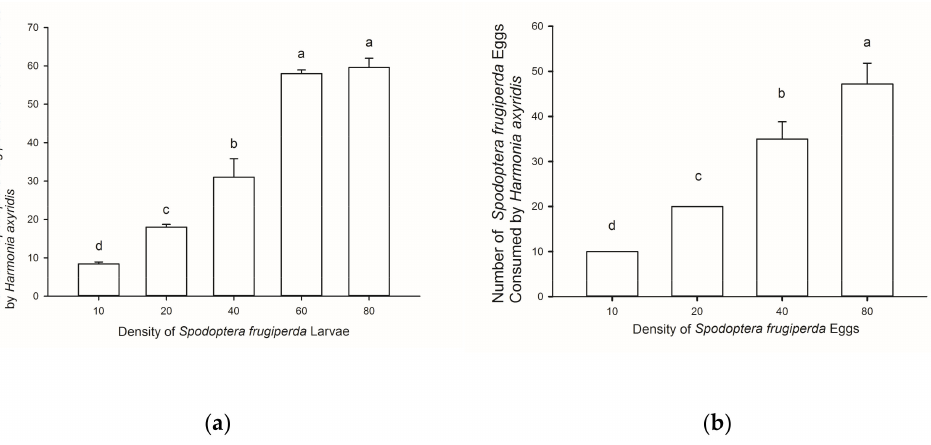
Figure 3. The average predation quantity of adult Harmonia axyridis on 1st instar larvae of Spodoptera frugiperda at different prey densities ( ± SE) ( a ) and the number of eggs consumed at different prey densities ( ± SE) ( b ). Different letters signify significant differences at p <